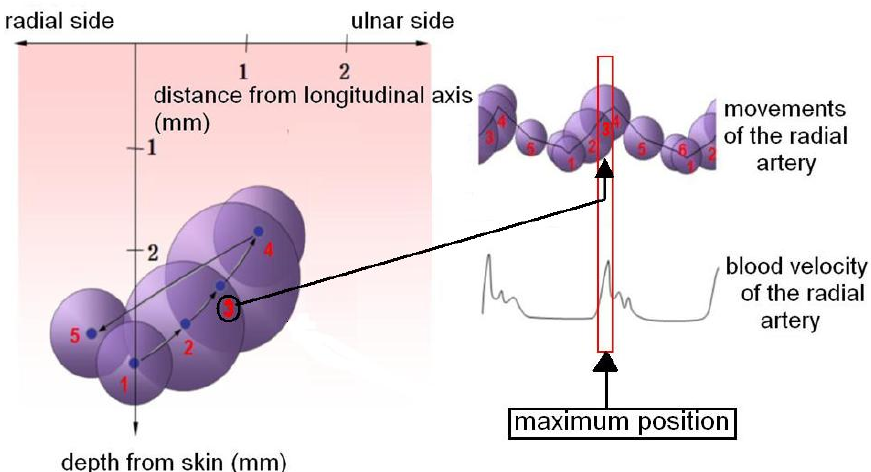
Figure 2. Schematic diagram of the three-dimensional motion of the radial artery, showing the relation between arterial pulse motionand blood flow in the radial artery. Here the maximum point means the largest diameter and blood velocity of the radial